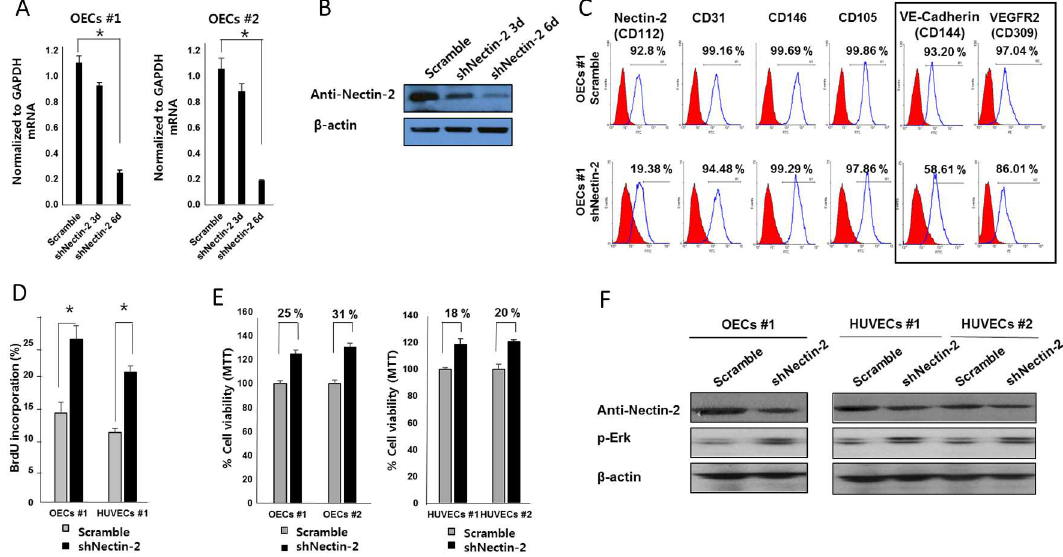
Fig 4. Nectin-2 knockdown increases OEC proliferation. OECs were infected with scramble shRNA or Nectin-2 shRNA lentivirus. (A) Nectin-2 mRNA expression levels were analyzed by quantitative RT-PCR ( P < 0.01). (B) Nectin-2 protein expression was analyzed by western blotting. (C) Representative FACS analysis of Nectin-2-knockdown in OECs. Cell- surface expression of VE-Cadherin (CD144) and VEGFR-2 was reduced by Nectin-2 knockdown. Other endothelial cell- surface markers were not changed in OECs. Cell proliferation was evaluated by BrdU and MTT incorporation. (D) The percentage of BrdU incorporation (mean ± SD) was analyzed for scramble and Nectin-2 shRNA in both OECs and HUVECs ( P < 0.01). (E) MTT assays performed on OECs and HUVECs ( P < 0.01). (F) Nectin-2 knockdown increased phospho- ERK activity. Nectin-2 was knocked down in OECs and HUVECs with shRNA, and the knockdown efficiency was monitored by anti-CD112 (Nectin-2) MAb in Western